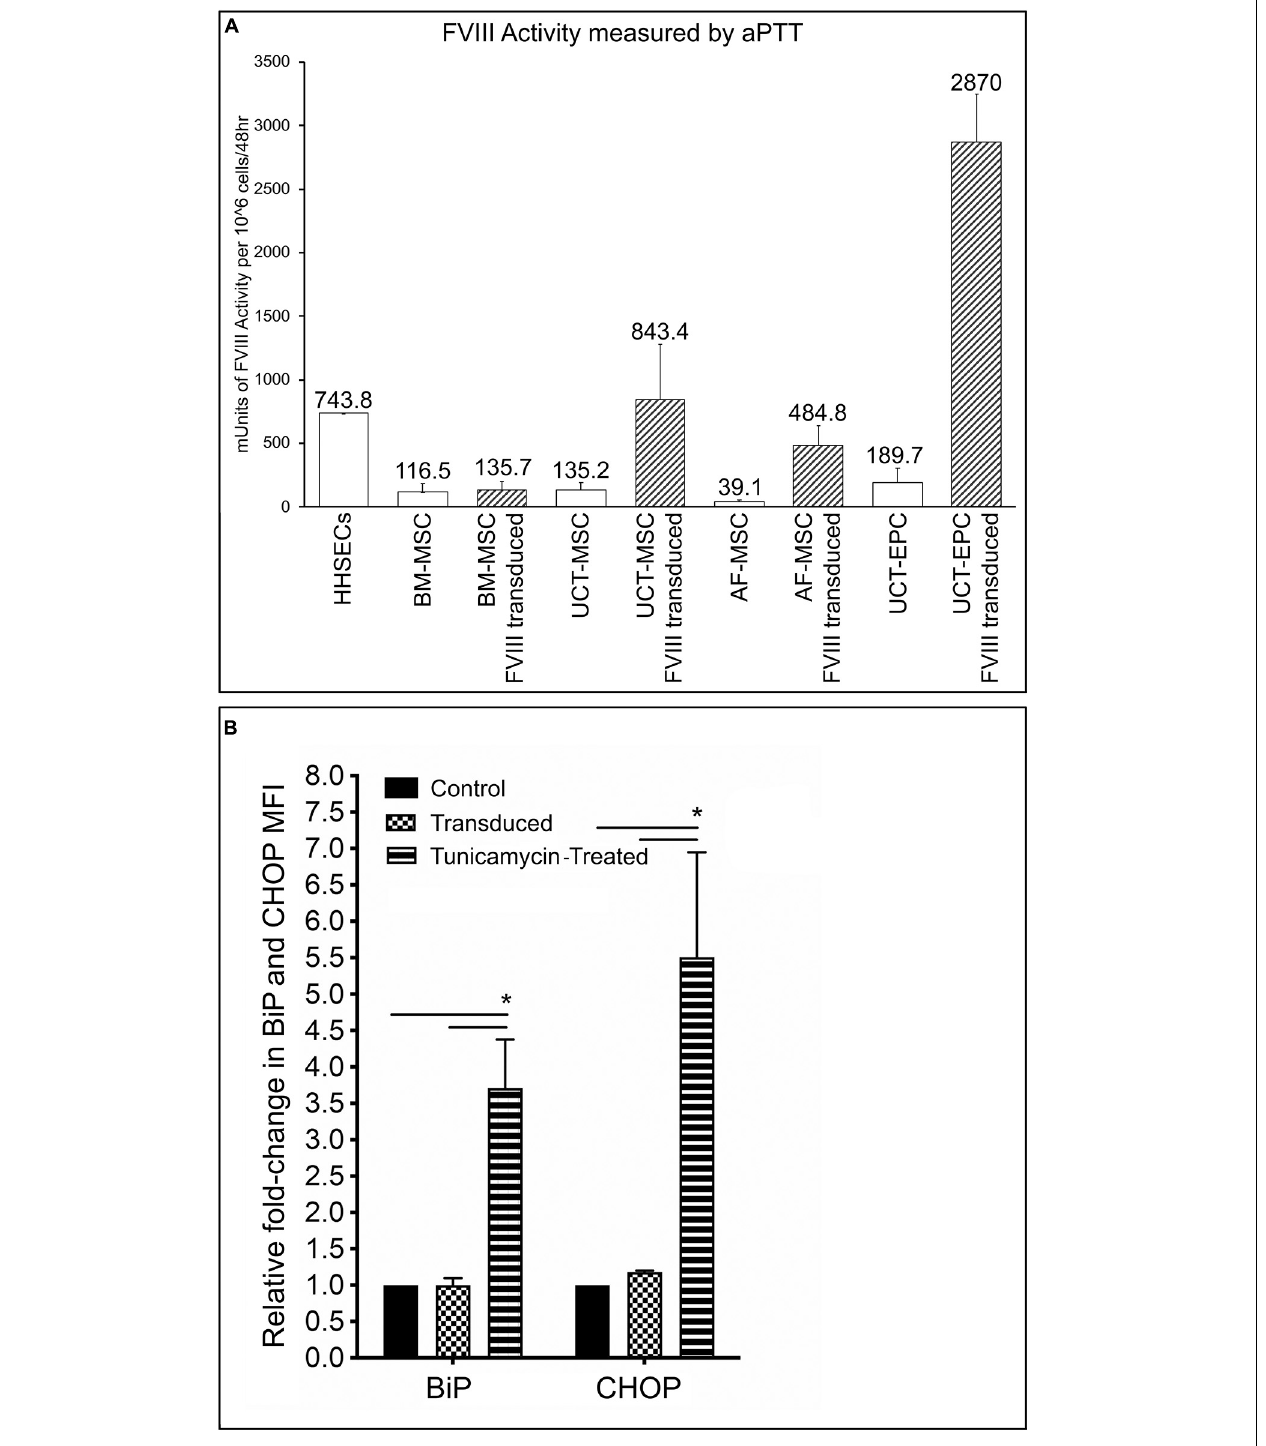
FIGURE 5 | (A) Measurement of FVIII:C activity by aPTT assay. 48-h supernatants were collected from each of the cell types, prior to and following transduction with the HSQ-encoding MMLV vector, and FVIII activity was measured by activated partial thromboplastin time (aPTT) assay. Values are expressed in mUnits of FVIII:C activity per million cells per 48 h. Error bars represent standard error of the mean (SEM). (B) Flow cytometric analysis of BiP and CHOP, in untransduced, transduced cells, and cells treated with tunicamycin (positive control). Fold-change in MFI of BiP and CHOP, was calculated by dividing the MFI of BiP or CHOP in transduced, or tunicamycin-treated cells, by the MFI of non-transduced cells, after subtracting respective isotype controls. ∗ p < 0.05.